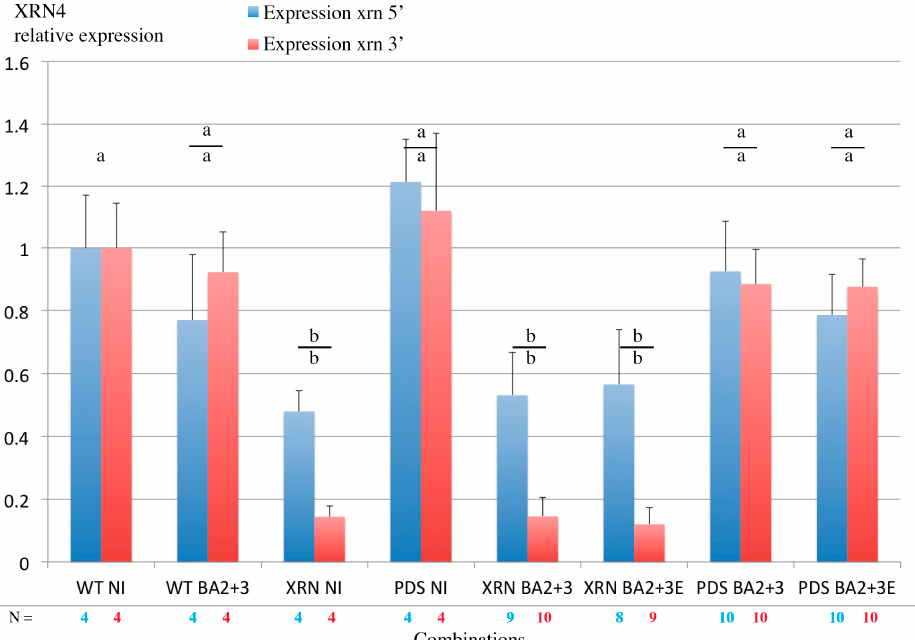
Figure 8. TRV-mediated VIGS of XRN4 is efficient in leaves. RT qPCR analyses of XRN4 mRNA within leaves from non-infected plants (WT NI), TRV-XRN (XRN), and TRV-PDS (PDS) silenced N. benthamiana leaves (NI) or rub-inoculated with RNA1+2BA2 supplemented with RNA3 (BA2+3) or RNA3E (BA2+3E). Non-silenced N. benthamiana inoculated with RNA1+2BA2 supplemented with RNA3 served as control (WT BA2+3). Values were normalized to a mock treated control plant (WT NI). Quantitative PCR was performed using specific primers targeting the 5 ′ (blue) and the 3 ′ (red) region flanking the XRN4 trigger sequence present in TRV RNA2 and GAPDH and PP2A cellular RNAs. The numbers of sampled plant are specified (N). Student test p- values were >0.005 (a) or <0.005 (b) using WT NI as reference (upper letter) or comparing 5 ′ and 3 ′ relative expression (lower letter).